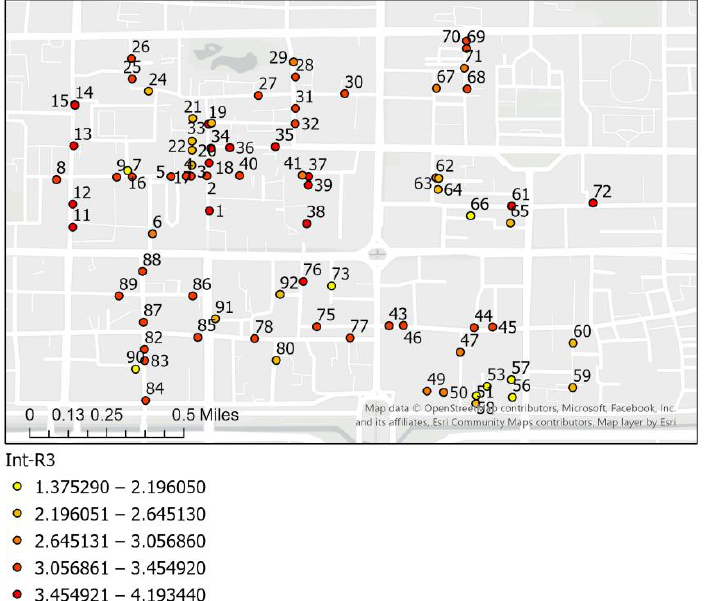
Figure 5. Local integration (Int – R3) of points based on axial map before and after the pandemic.